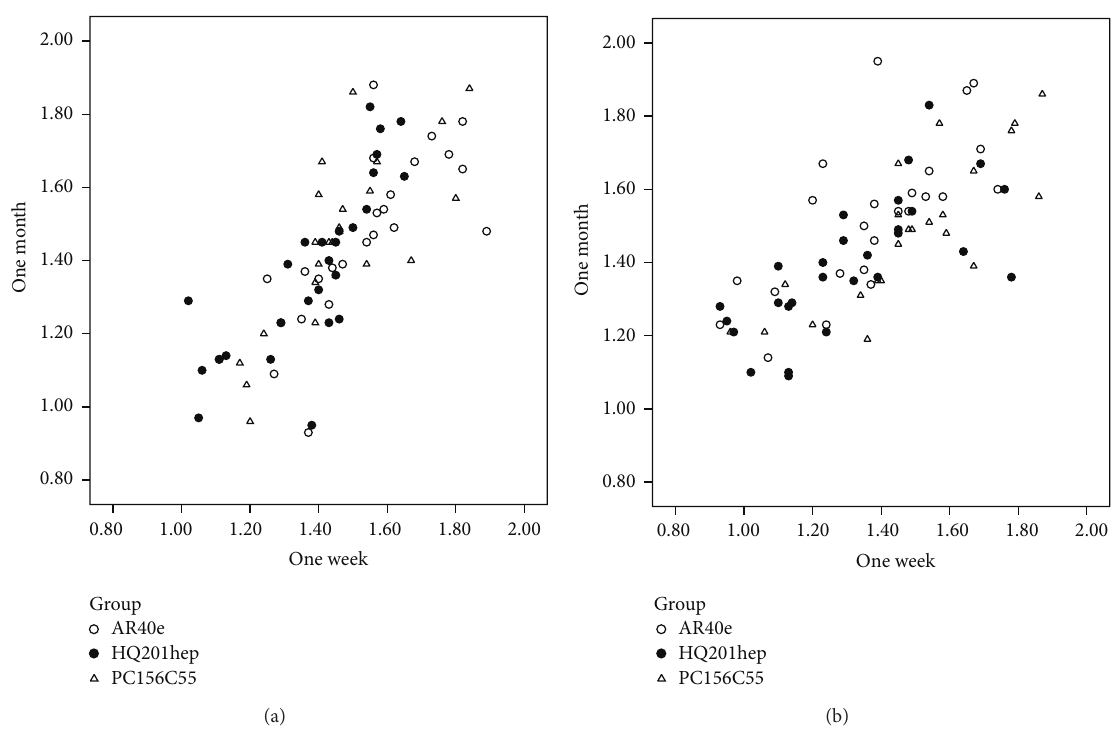
Figure 1: (a) The scatterplot of the straylight values of three IOLs 1 week after surgery ( 𝑥 -axis) and 1 month after surgery ( 𝑦 -axis) with natural pupil. (b) The scatterplot of the straylight values of three IOLs 1 week after surgery ( 𝑥 -axis) and 1 month after surgery ( 𝑦 -axis) with dilated pupil.